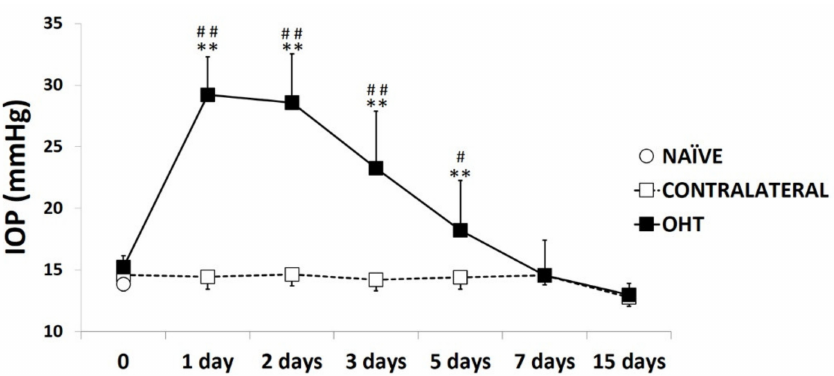
Figure 1. Intraocular pressure (IOP) values at different times after laser-induced ocular hypertension (OHT). Variation over time in intraocular pressure IOP values after OHT induction. Points show the mean levels ( ± SD) of IOP previously and at 1, 2, 3, 5, 7, and 15 days after laser OHT induction in naïve eyes, ocular hypertension eyes (OHT), and contralateral eyes. Statistical significance indicators: ** p < 0.01 vs. naïve; ## p < 0.01 vs. contralateral; # p < 0.05 vs.